Question: Looking at the figure, what chart type is it?
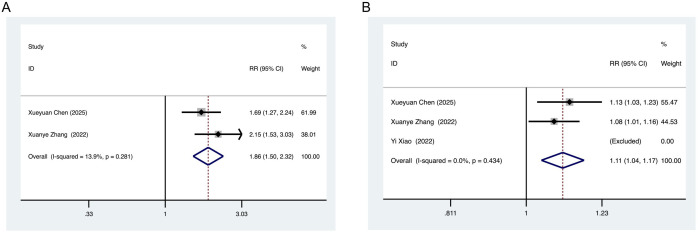
Answer: forest